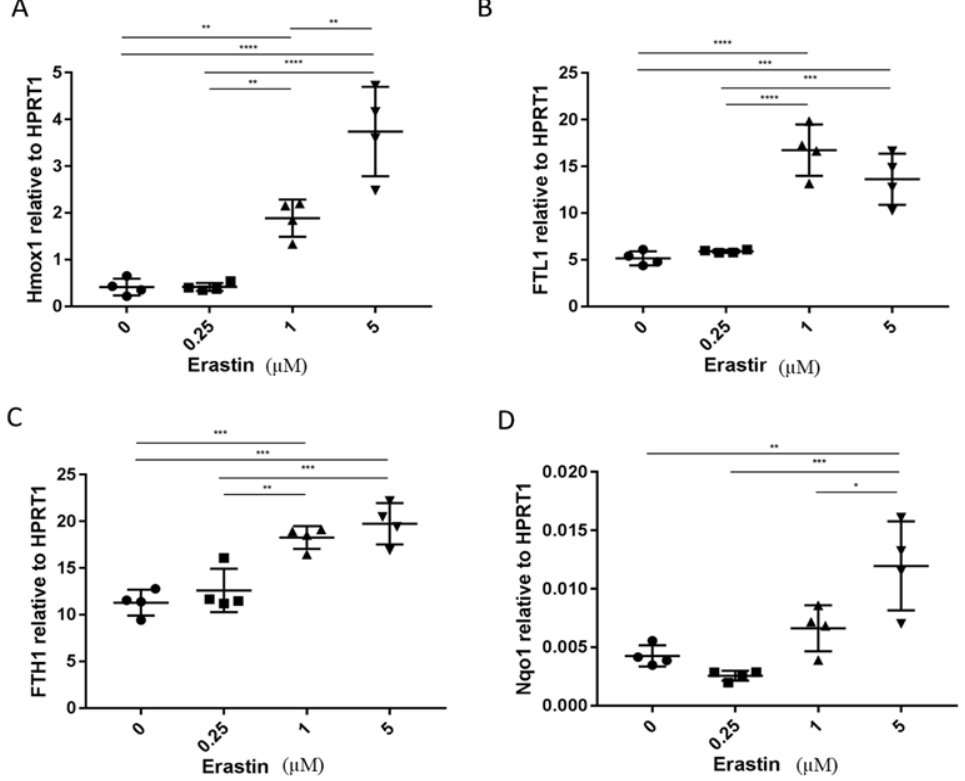
Figure 2. Erastin induced ferroptosis markers in a dose-dependent manner. MC38-luc (6.0 × 10 4 cells) were plated in a 24-well plate and cocultured with different concentrations of erastin (0, 0.25, 1.0, 2.5 µM). After 24 h, cells were collected and cell lysates were used to extract RNA to determine the expression levels of Hmox1, FTL1, FTH1, and Nqo1 ( A – D ). The expression levels of all markers are relative to the housekeeping gene HPRT1. Values are mean ± SD. One-way ANOVA was used to analyze the statistical significance (*, p < 0.05; **, p < 0.01; ***, p < 0.001; ****, p < 0.0001).